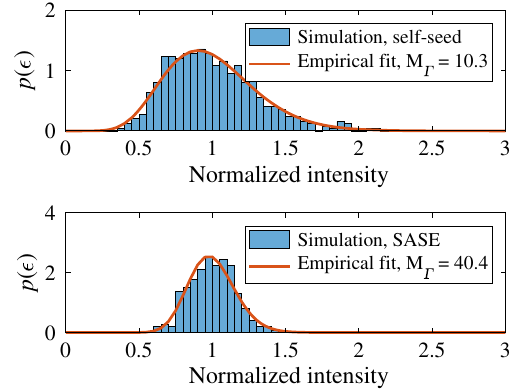
FIG. 6. The effective number of modes M as a function of the integration bandwidth for different conditions listed in the